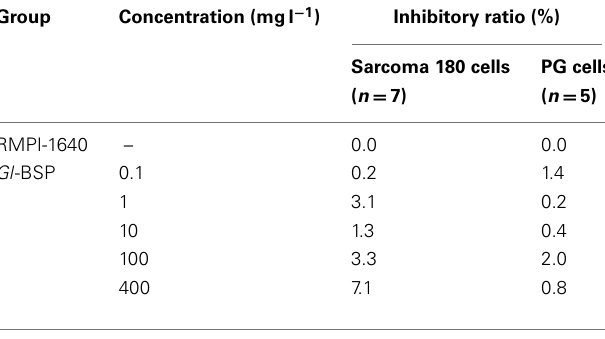
Table 2 | Effect of Gl -BSP on proliferation of Sarcoma 180 cells and PG cells in vitro ( ¯ x ± s).